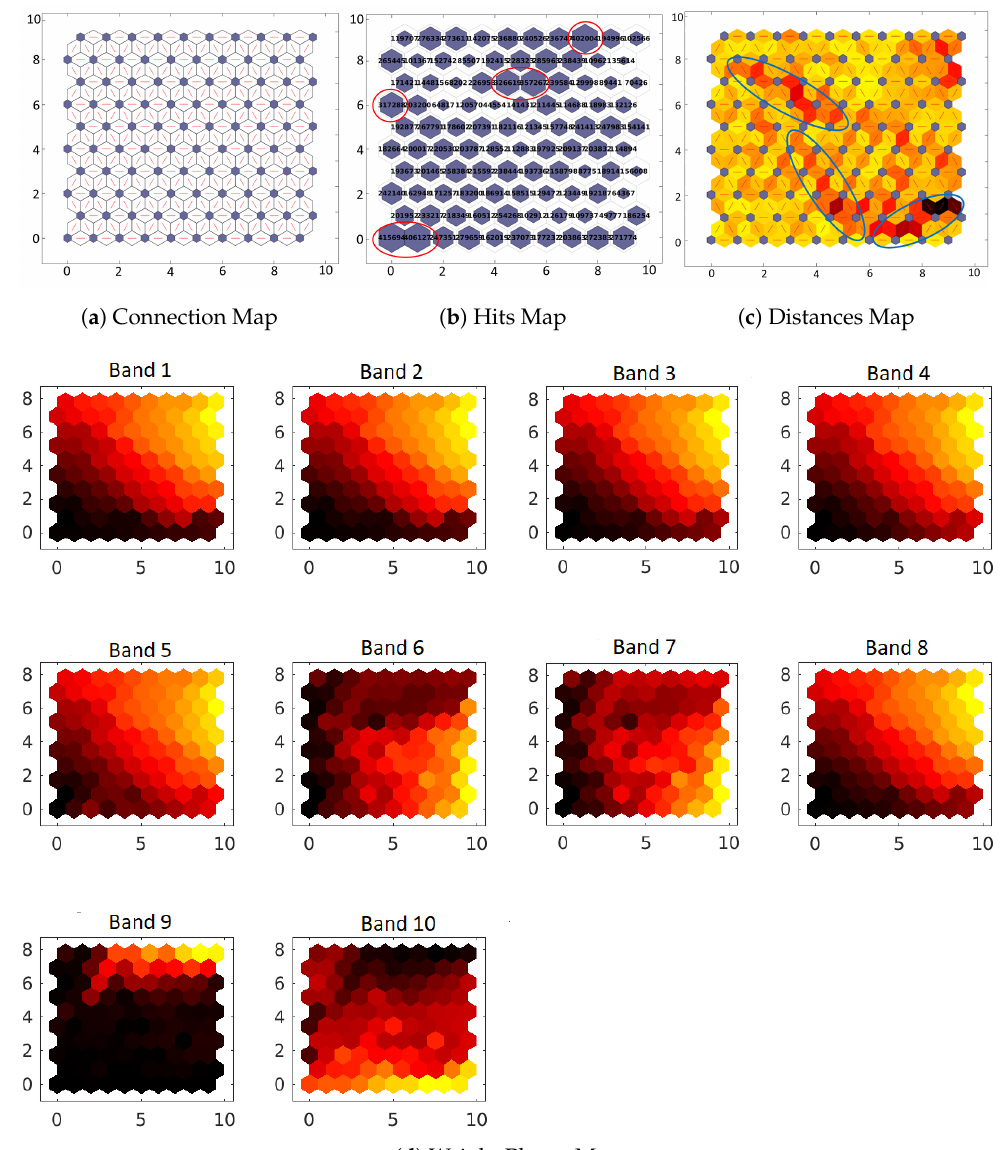
Figure 7. The four SOM plots. A total of 100 neurons are plotted on a 10 by 10 gridded plane. Axis x and axis y are the neuron location indices. ( a ) The connection map displays the neuron topology, ( b ) the hits map represents the number of vectors associated with each neuron, ( c ) the SOM neighbor weight distance map displays the distance between each neuron, and ( d ) displays the weight of each input component (spectral bands) in a 2D